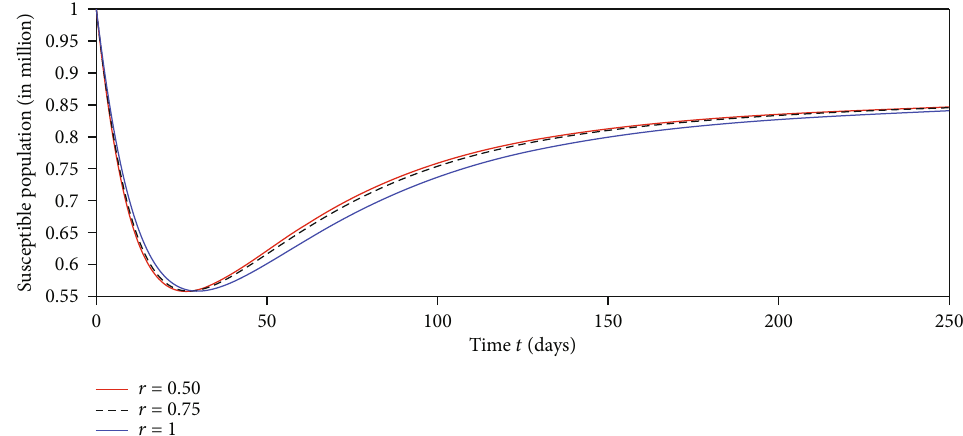
Figure 1: Graphical representation of the approximate solution of a susceptible class at three di ff erent fractionals.